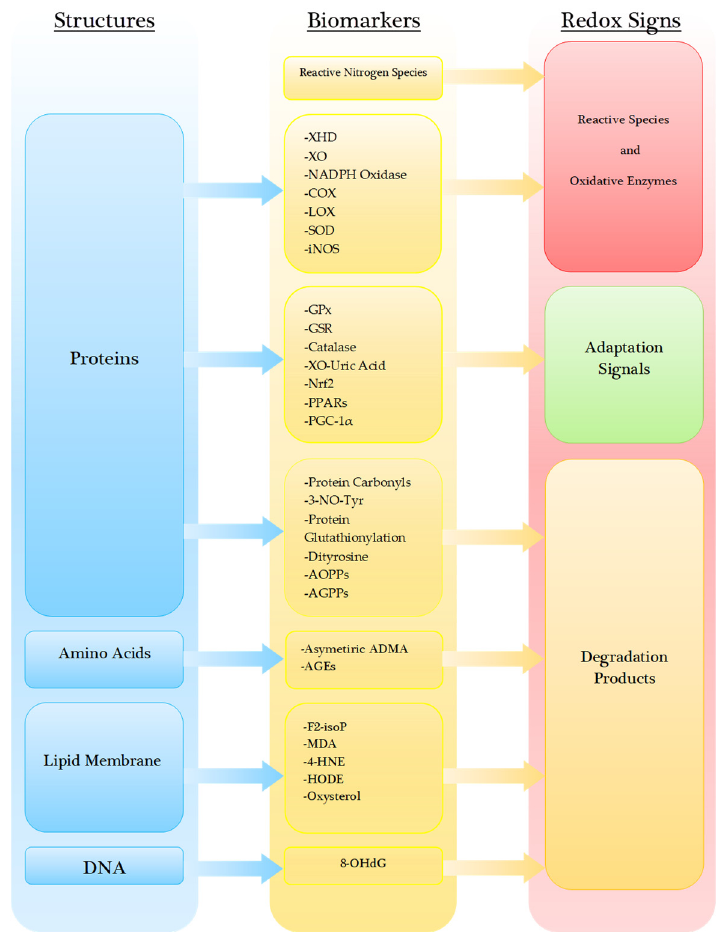
Figure 3. Classification of redox biomarkers according to cellular structures, biomarkers, and their modes of action in redox homeostasis.